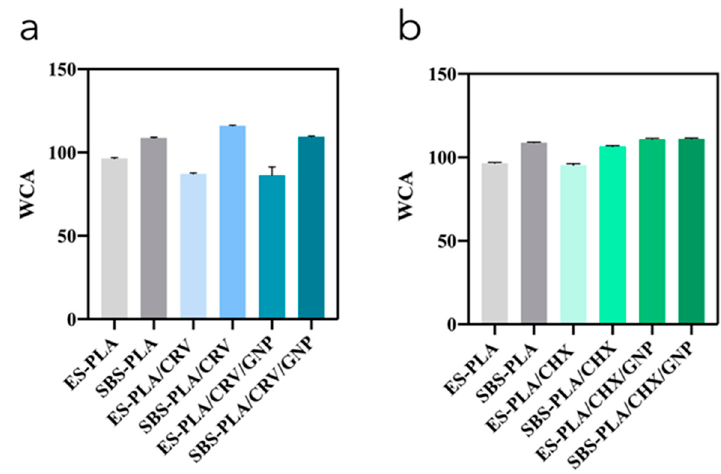
Figure 9. Water contact angles of ES and SBS nanofiber mats filled with CRV (a) and CHX (b). In regard to CRV-containing systems, the addition of it to electrospun membranes induces a decrease in the PLA hydrophobic behavior [13,51]. In fact, SBS-PLA/CRV shows in the wettability is reported [34] with WCA values decreasing from 96° of neat PLA to 87° and 86° of ES-PLA/CRV and ES-PLA/CRV/GNP, respectively. SBS systems, instead, show a higher hydrophobic behavior [52]: SBS-PLA, SBS-PLA/CRV, and SBS-